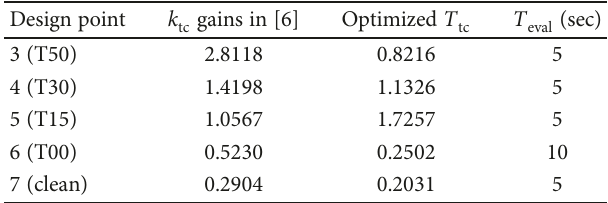
T Table 3: k tc gains in [6], tc using our CAS gains in Table 2,